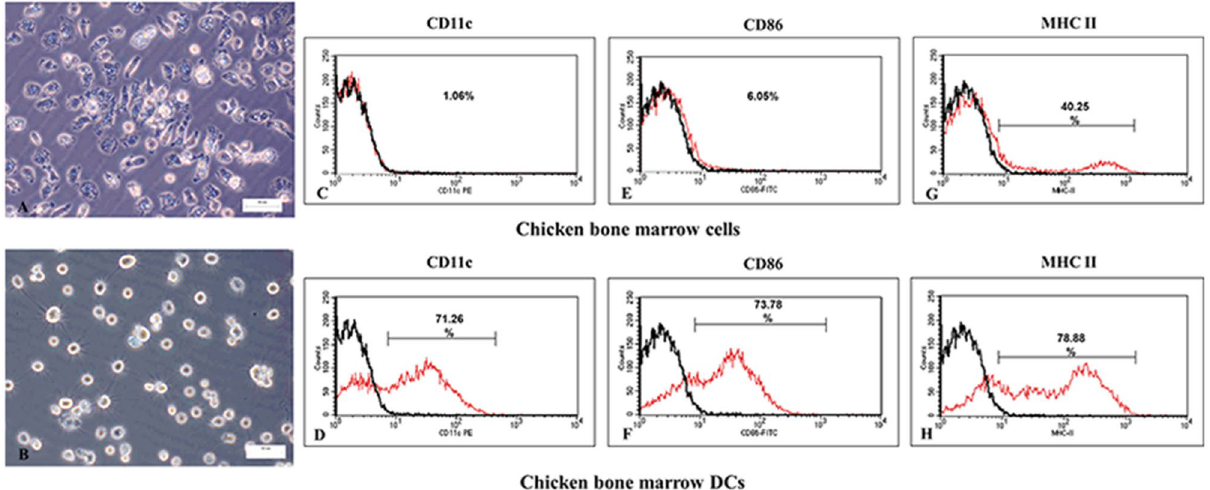
Figure 2. Preparation and identification of chicken bone marrow dendritic cells. ( A ) Morphology of adherent of chicken dendritic cells (DCs) at day 6. During the inducing differentiation process, the circular monocytes gradually adhered to the plate and formed cell clusters. The adherent DCs were fusiform in shape or polymorphic with obvious burr-like protrusions on the cell surface. ( B ) Morphology of DCs digested by trypsin at day 6. Polymorphic DCs switched to a spherical shape after digestion with trypsin, and the protrusions on the cell surface presented a needle-like form which varied in length. ( C – H ) Surface marker detection of chicken dendritic cells by flow cytometry. CD11c, CD86 and MHC II expression on the surface of chicken bone marrow- derived dendritic cells (DCs) cultured for 6 d were detected by fluorescence-activated cell sorting. Expression of the three surface markers was up-regulated in the chicken bone marrow-derived DCs after granulocyte macrophage-colony stimulating factor and interleukin-4 induction compared to chicken bone marrow cells. Isotype matched controls (black line) and the test markers (red line) are